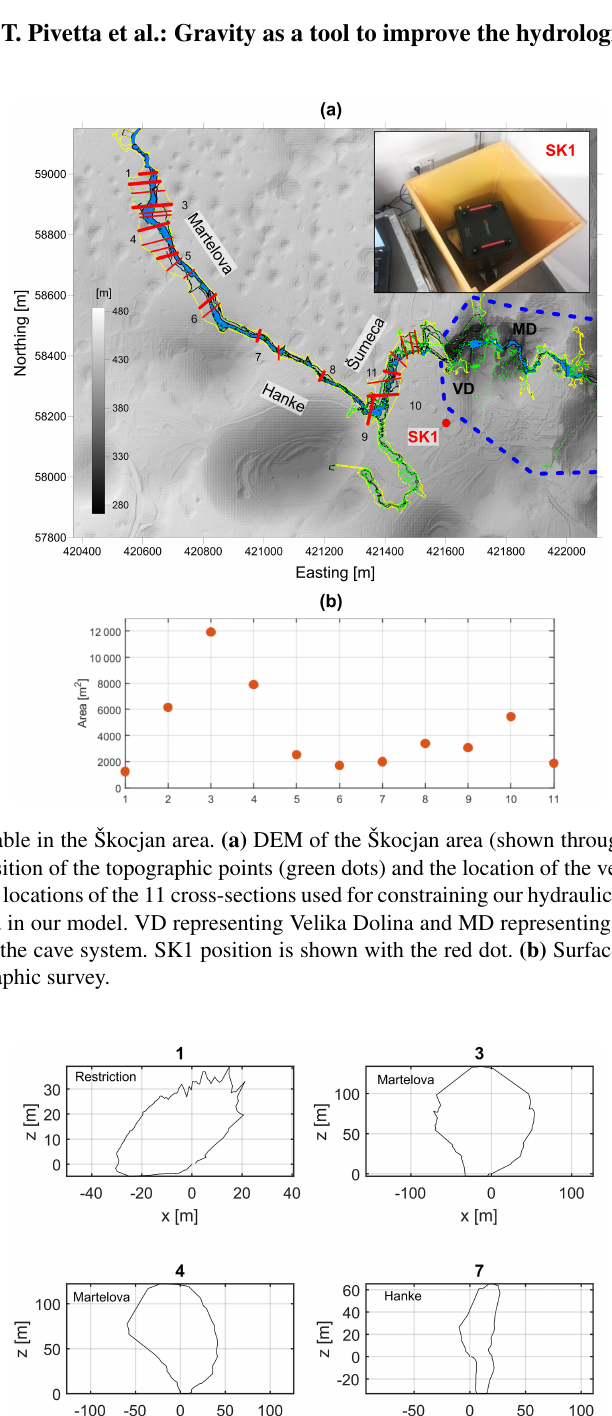
Hydrol. Earth Syst. Sci., 25, 6001–6021, 2021